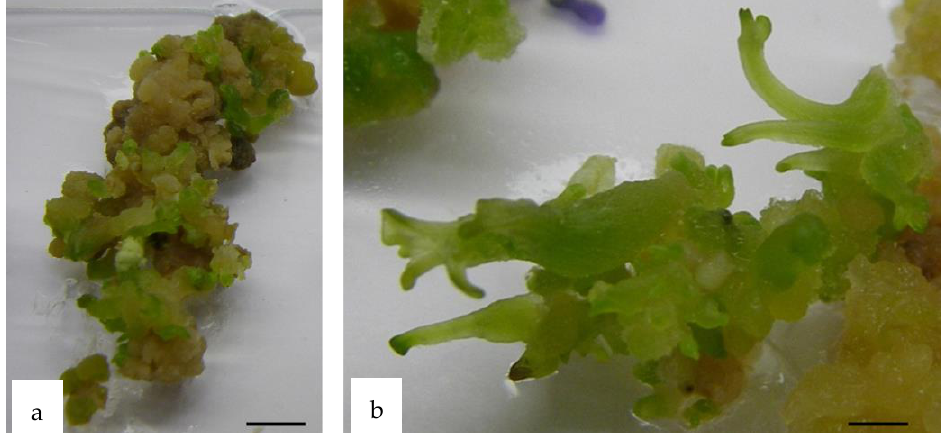
Figure 7. Embryo production from Medicago truncatula HR explants. ( a ) WUS embryogenic calli produced on root segments of M. truncatula after 3 weeks of culture and ( b ) WUS somatic embryos at different developmental stages (c: cotyledonary stage and g: globular stage) produced on embryogenic calli after 4 weeks of culture on M0 medium (without plant growth regulators). Bar 1.0 cm ( a ) Bar 0.5 cm ( b ).